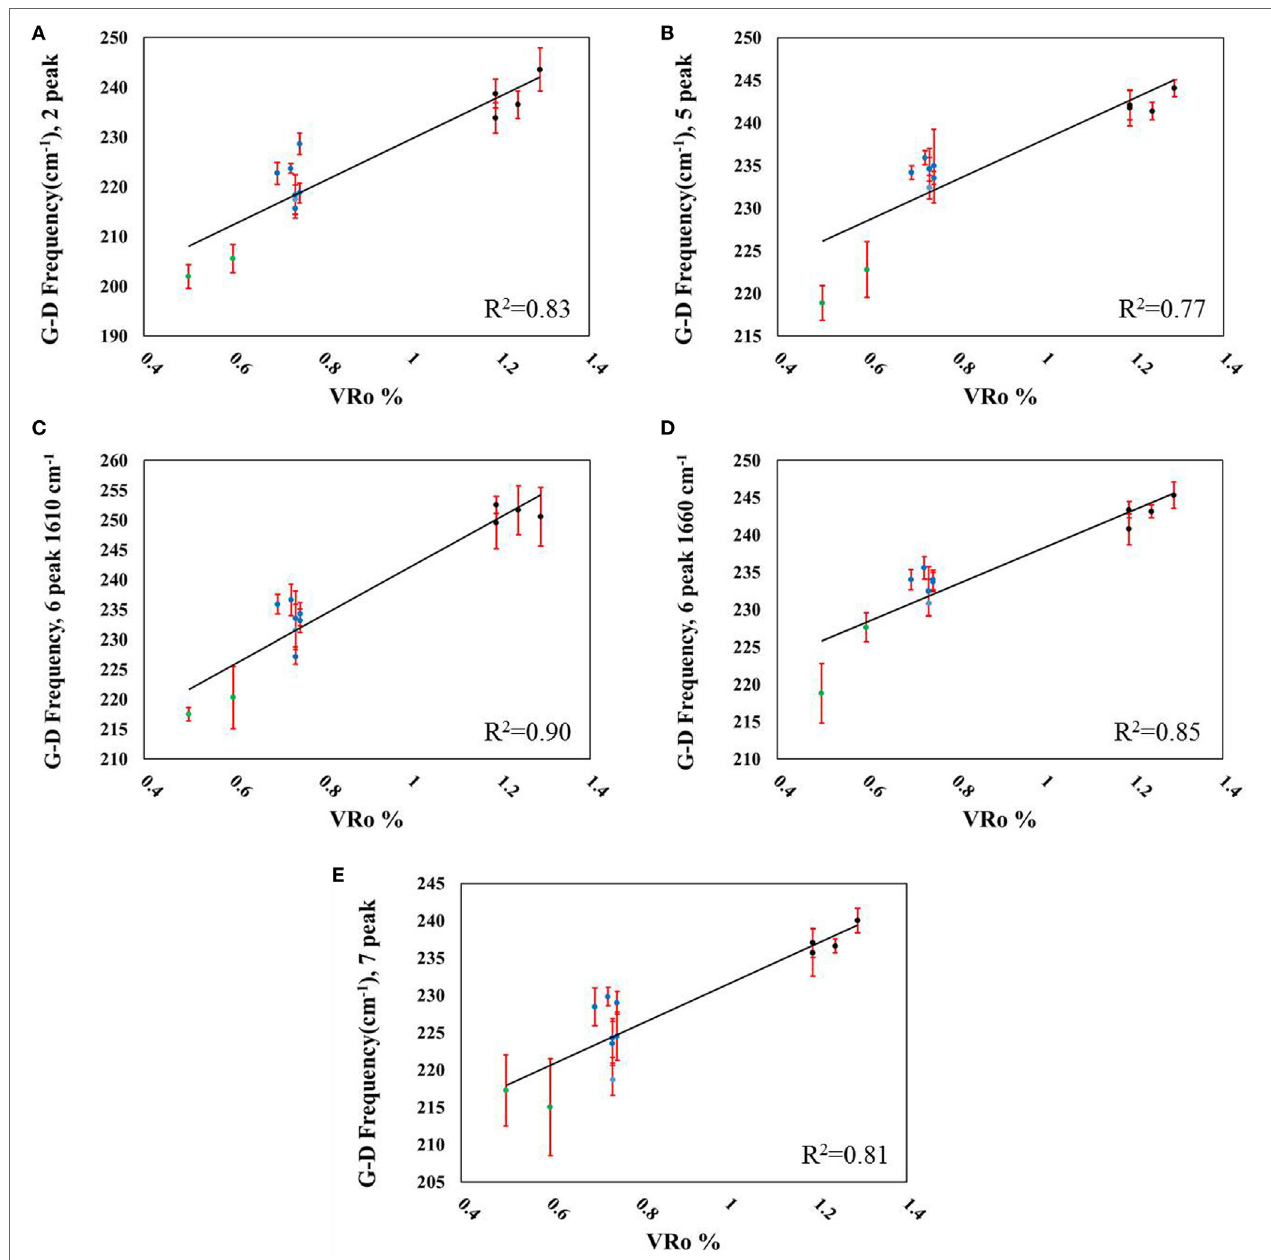
FigUre 6 | Correlations between G–D-frequency difference and measured VRo% using (a) two peaks ( R 2 = 0.83), (b) five peaks ( R 2 = 0.77), (c) six peaks including the D2-band ( R 2 = 0.90), (D) six peaks including a ~1,660 cm − 1 peak ( R 2 = 0.85), and (e) seven peaks ( R 2 = 0.81). Data point legend: green = Aristech wells, blue = Interstate/Columbia wells, black = EQT